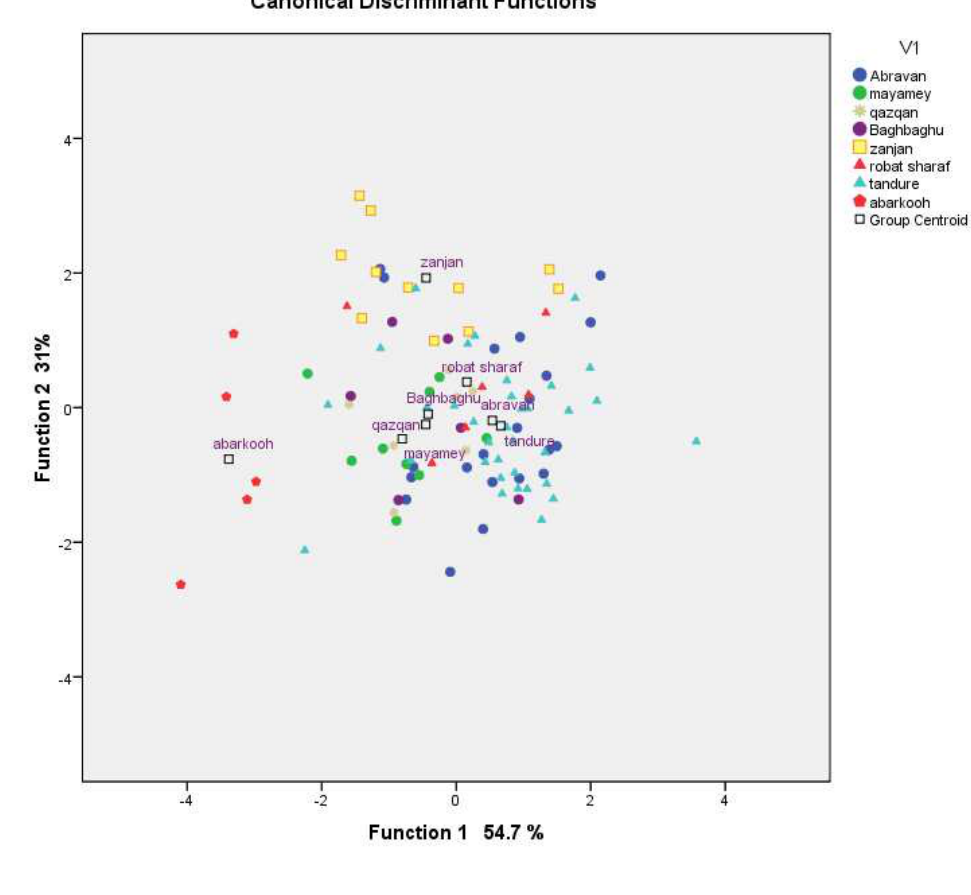
FIGURE 18 : Scatter plot of CDA analysis on M/1 measured variables in Meriones